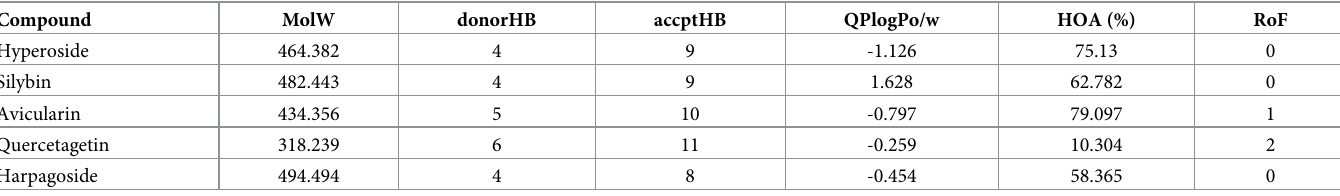
Table 2. ADME properties of the compounds. Compound